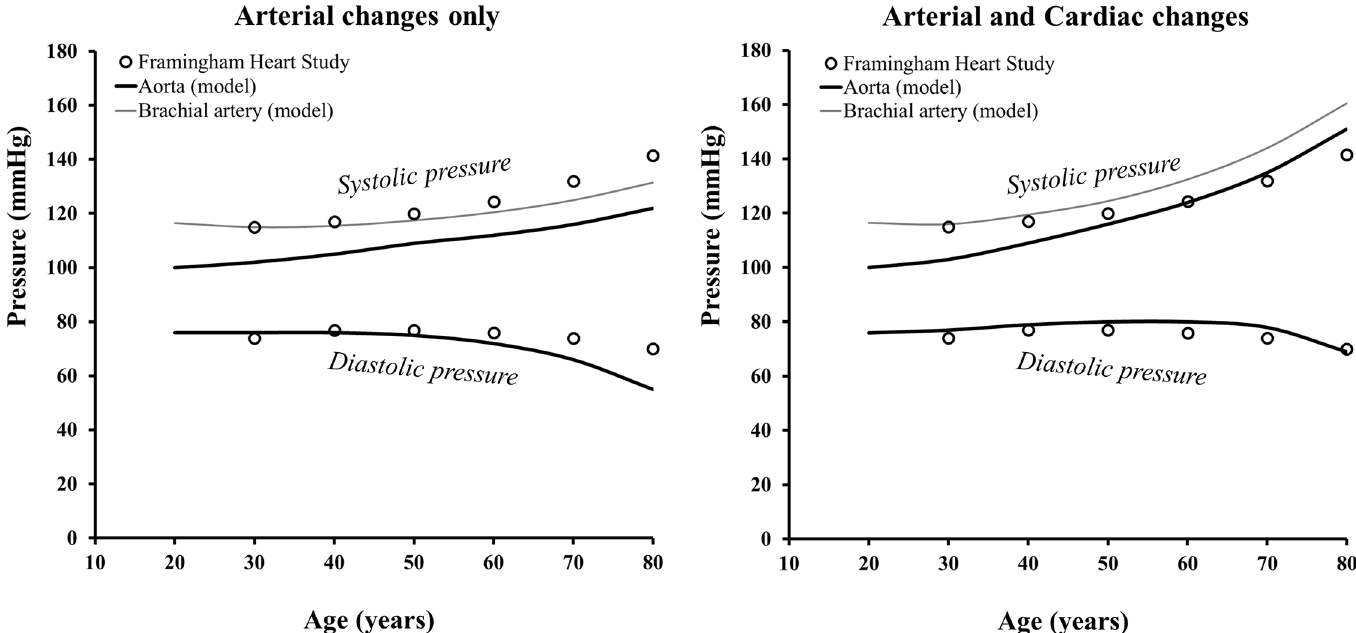
Fig 4. Comparison between the model ’ s aortic systolic and diastolic pressures changes with age and population data for brachial pressure. (On the left) Simulations for arterial parameter changes only and (on the right) for arterial and cardiac parameter changes combined. Parameters for the arterial changes are prescribed, whereas parameters for the cardiac changes are computed through physiological rules. The thin grey line represents derived brachial systolic pressure, obtained accounting for the amplification between aortic and brachial systolic pressure based on data reported by Avolio et al.